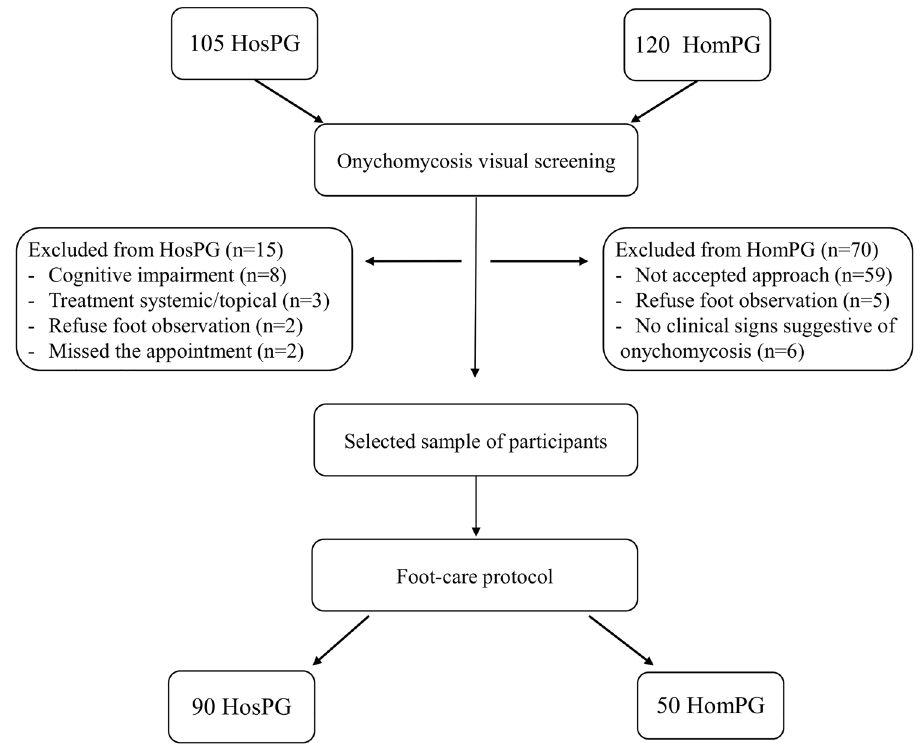
Figure 1. Hospital Patients Group (HosPG) and Homeless People Group (HomPG) flow